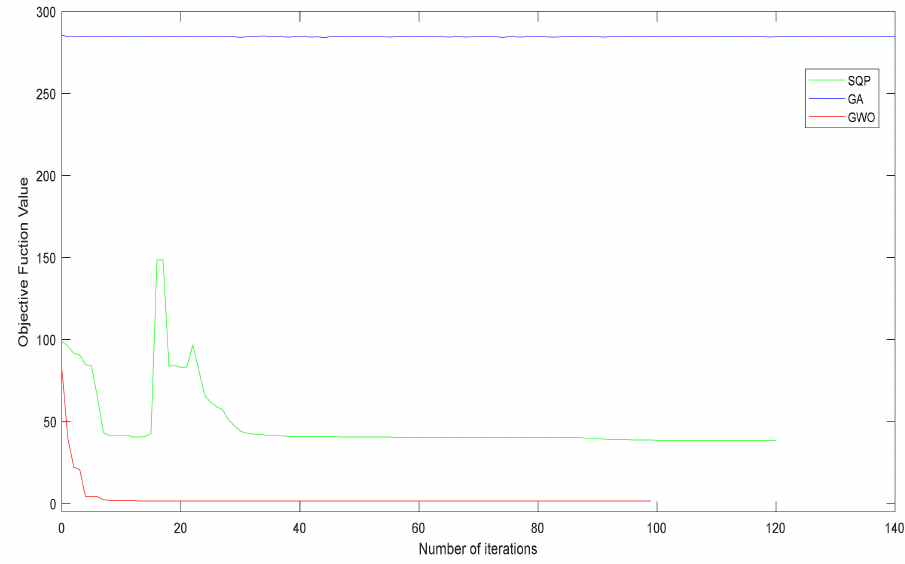
Figure 15. Convergence characteristics of the optimization algorithms used for the 12-DOF model (shaking loads only).